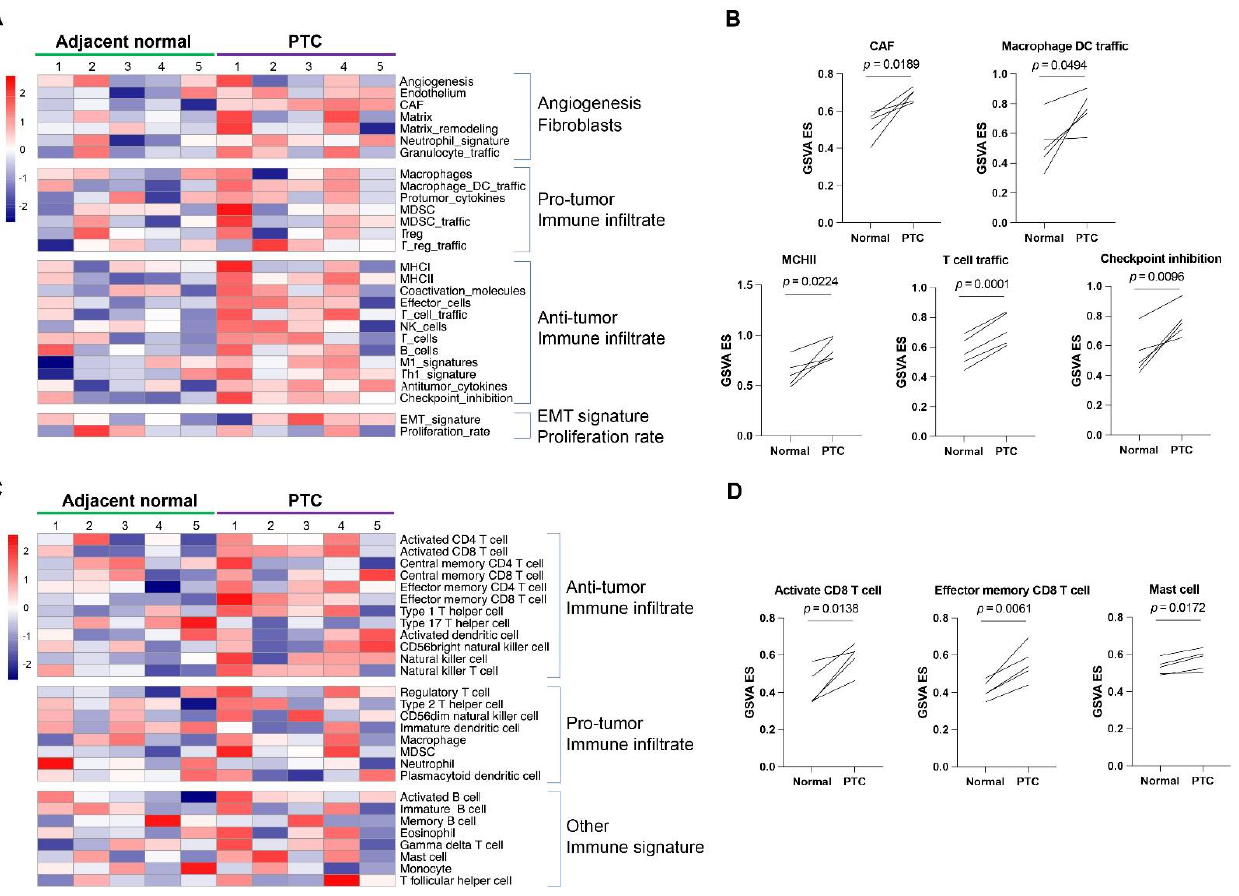
Figure 4. GSVA of the signatures of tumor infiltrating immune cells and tumor microenvironment. ( A ) Heatmap of enrichment scores of 28 tumor microenvironment-related gene sets. ( B ) The gene sets with significant difference between the groups. ( C ) Heatmap of enrichment scores of gene sets of 28 tumor-infiltrating immune cells. ( D ) The gene sets with significant difference between groups. Paired t -tests were conducted.